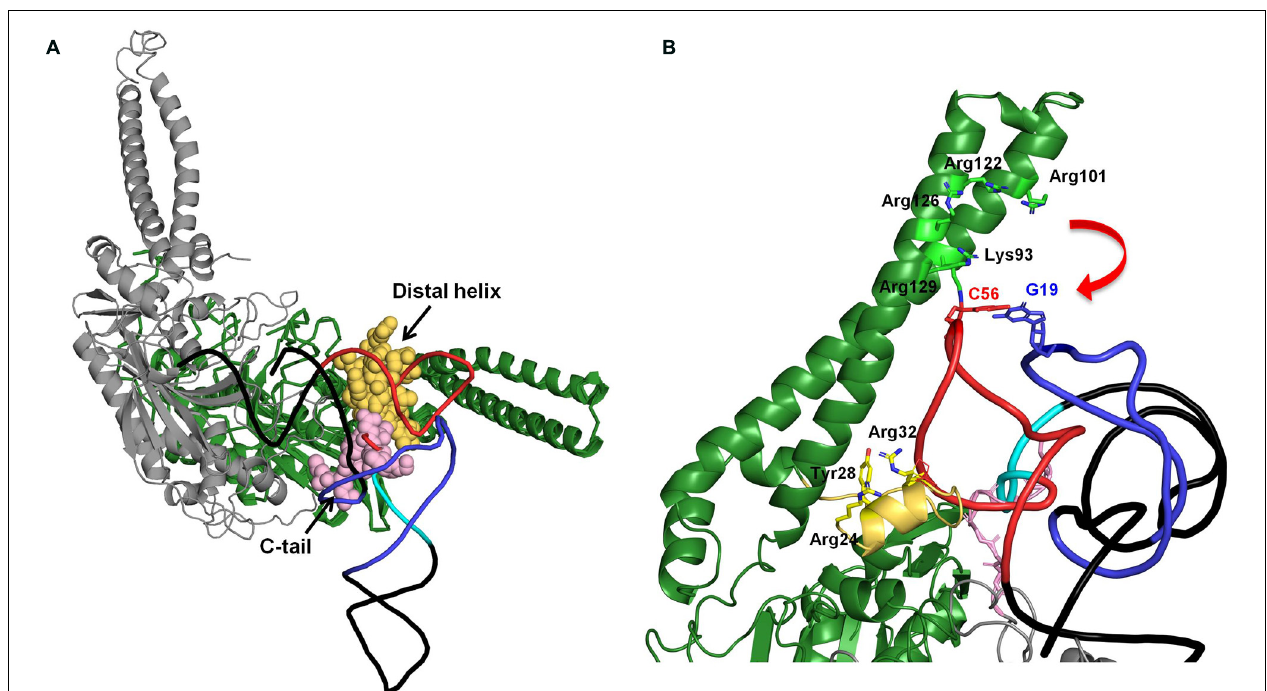
and red, respectively. (B) Putative interactions between the N-terminal coiled–coil region and the C-tail distal helix with the T-arm of the tRNA. The interactions are inferred by mutational analysis of the enzyme (Chimnaronk etal., 2005). Residues in N-terminal coiled–coil region and distal helix involved in the interaction with tRNA are shown in stick model (Chimnaronk etal.,